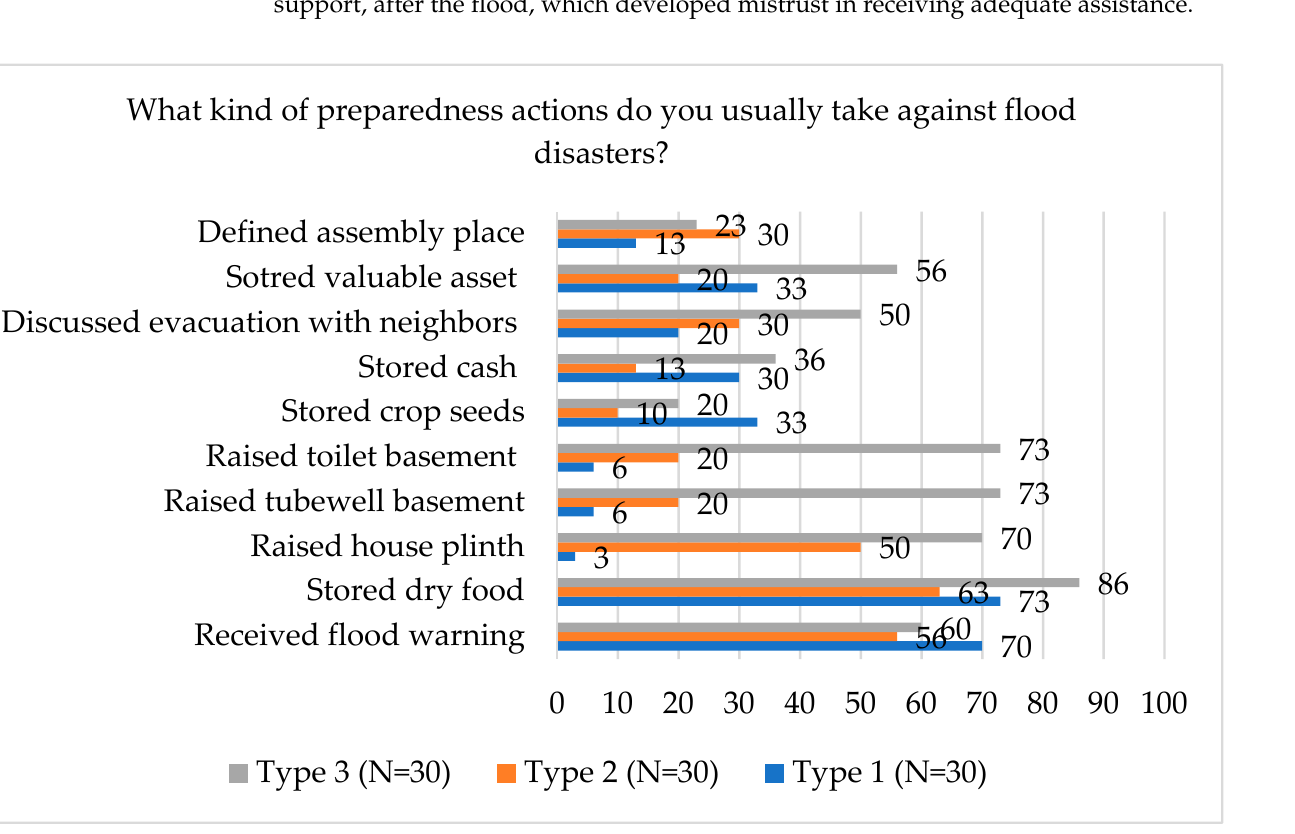
Figure 5. Status (in percentage) of flood preparedness actions taken by respondents in all three settlements (source: questionnaire survey).